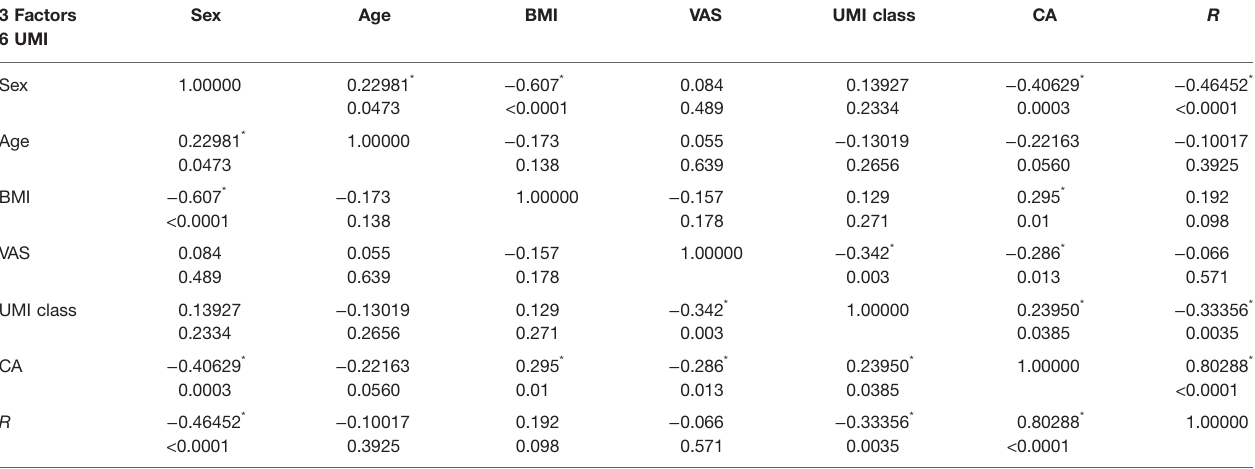
TABLE 3 | Pearson analysis between different factors (the number at the top of each unit is a correlation coef fi cient, and the value below is a p -value). Gender: male=1, female=2. 3 Factors 6 UMI